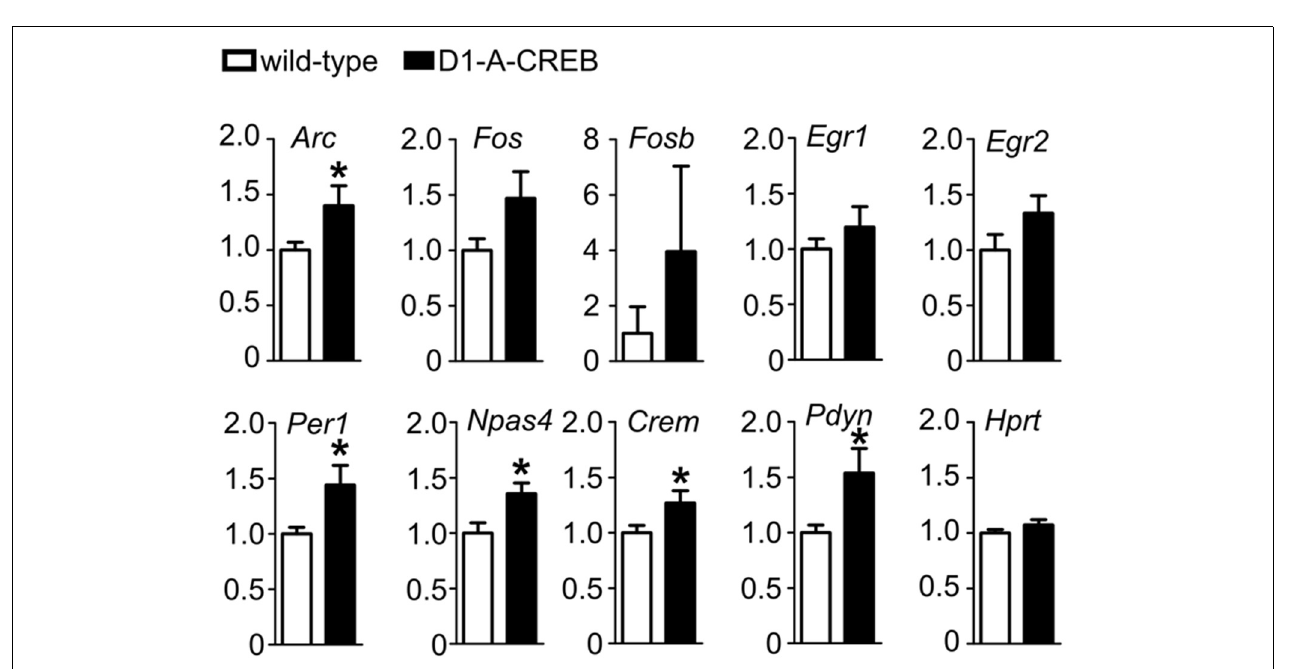
FIGURE 6 | Effect of A-CREB transgene on cocaine-dependent induction of activity-dependent genes. The graphs show mean abundances (8 mutants and 13 controls) of activity-dependent transcripts in mice 1h after